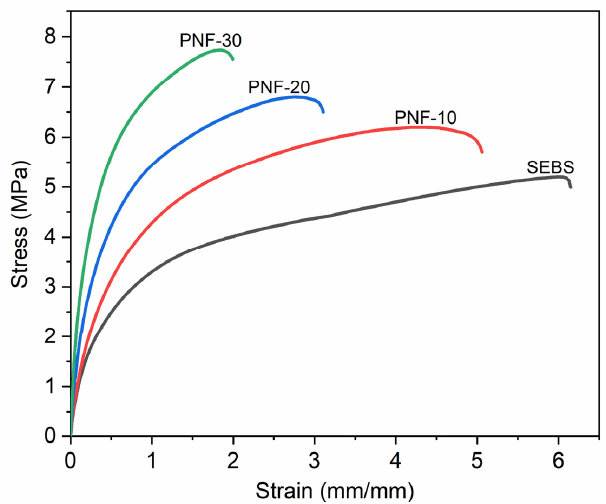
Figure 4. Tensile stress vs. strain curves of the matrix and the composites. Table 2. Tensile behavior of the materials.